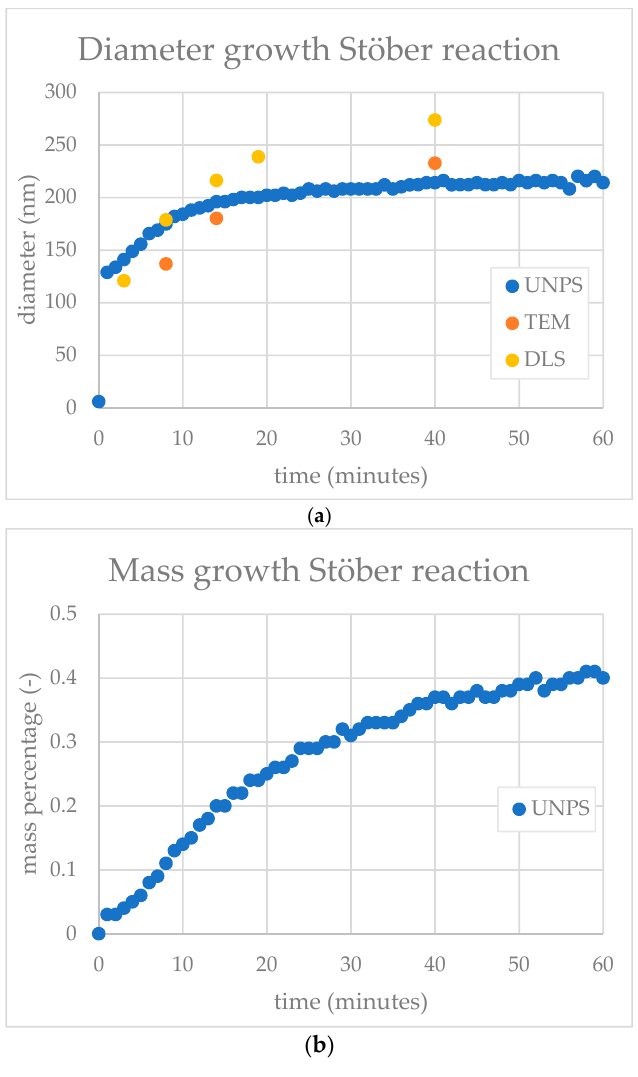
Figure 8. ( a ) The mean diameter of the Silica particles measured by the UNPS (blue), TEM (red), and dynamic light scattering (DLS) (yellow), during the Stöber reaction. ( b ) The mass percentage of the Silica particles measured by the UNPS during the Stöber reaction.